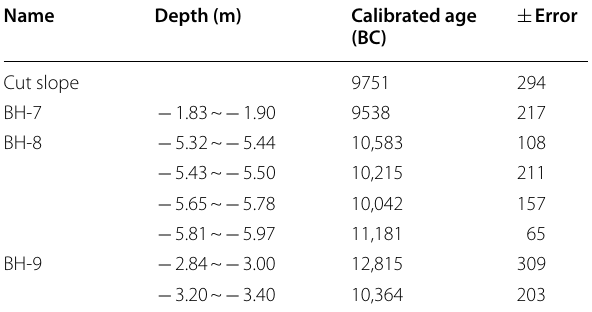
Table 2 Obtained ages of organic soils found at BH-7, BH-8, BH-9, and the cut slope